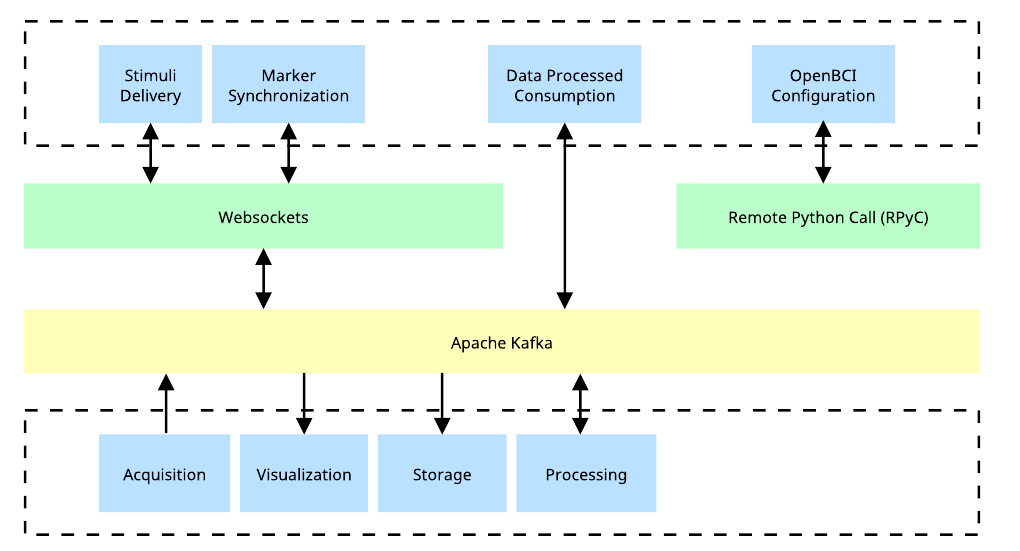
Figure 5. Distributed system implementation using Apache Kafka. Generation and consumption of real-time data are depicted, as well as the intermediation of a system that utilizes Websockets for additional tasks. Blue blocks depict tasks that can be executed independently across different processes or computing devices. The implementation of Apache Kafka serves as a mediator between various components and enables a seamless and efficient flow of information. Green blocks represent client-server communication protocols that are distinct from Apache Kafka.